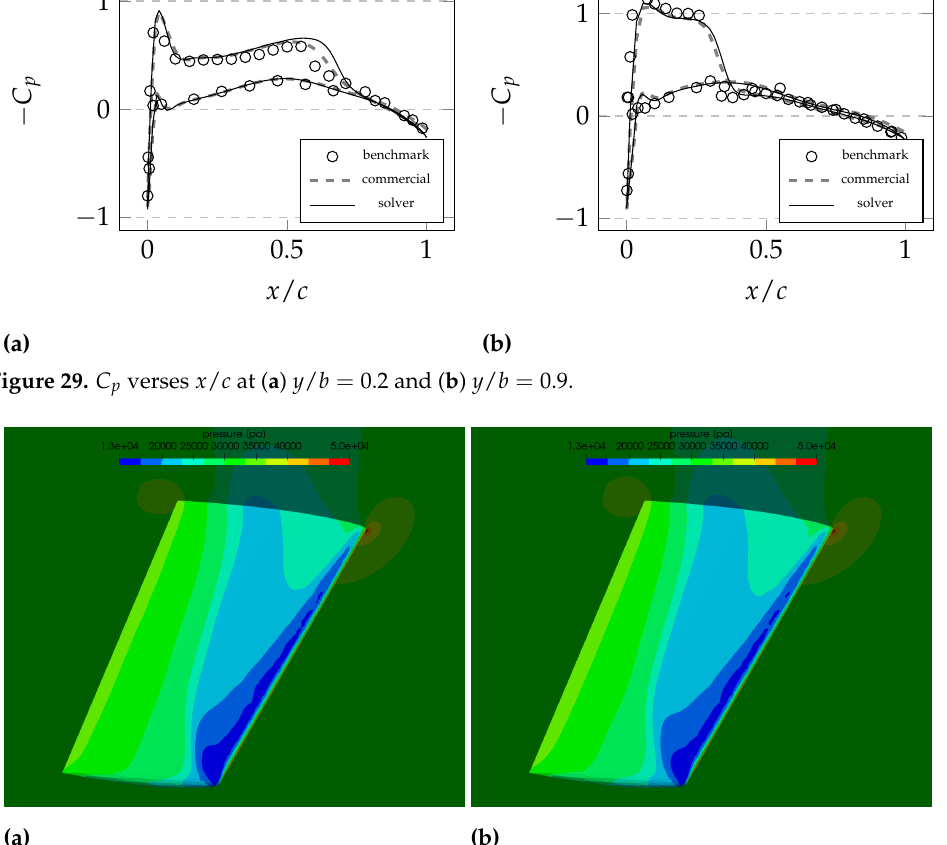
Figure 30. Pressure distributions over the wing as produced by the (a) commercial package and (b) the current solver